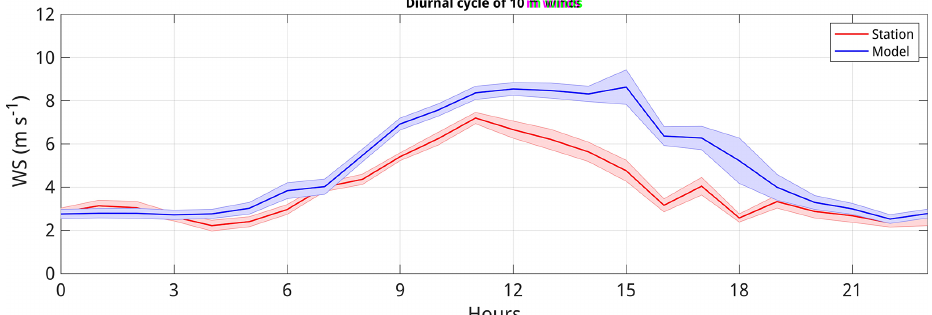
Figure 4. Diurnal profile of the model-simulated wind speeds compared to station data over the study period (4–31 August 2015) at KAUST (22.30 ◦ N, 39.10 ◦ E). The shading represents the standard error of the mean calculated from the hourly wind